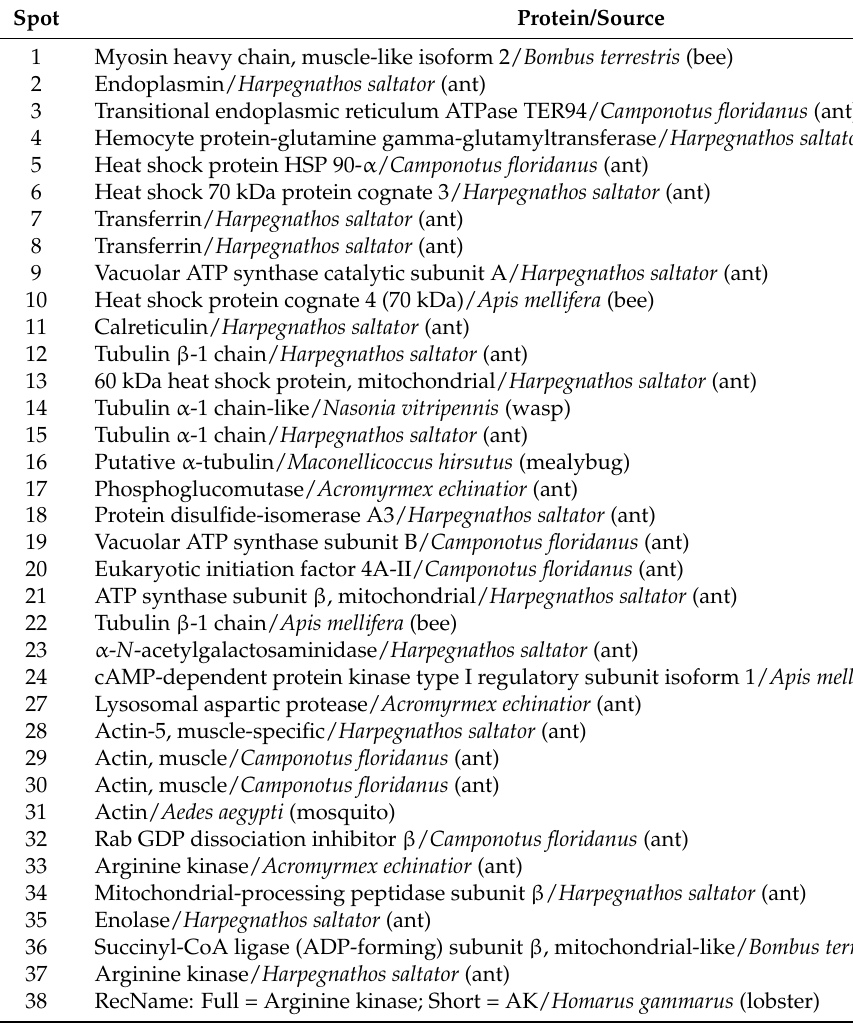
Table 1. Identified proteins in Neoponera villosa venom. MW: Molecular